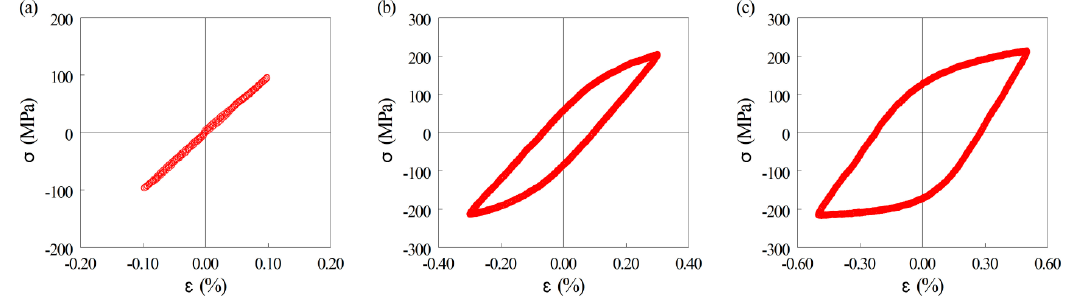
Figure 6. Saturated hysteresis loops for three different applied strain amplitudes: ( a ) ε a = 0.1%; ( b ) ε a = 0.3%; ( c ) ε a = 0.6%.